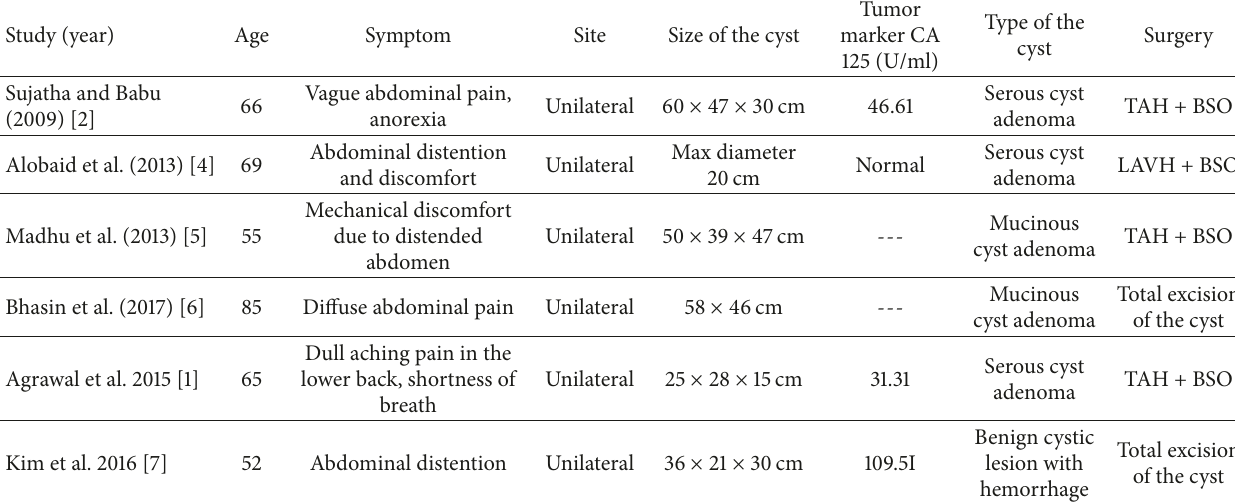
Table 1: Giant ovarian cysts in postmenopausal women: literature